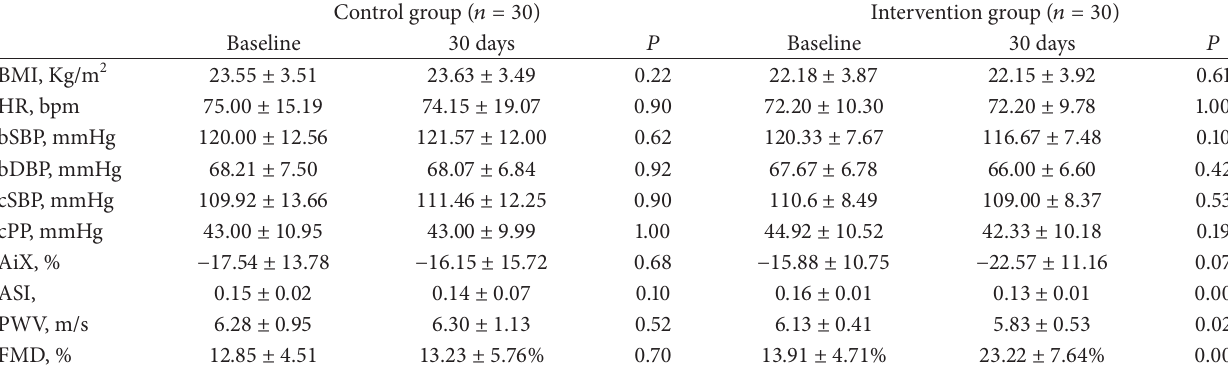
Table 2: Variation of the clinical parameters per group and per assessment moment.